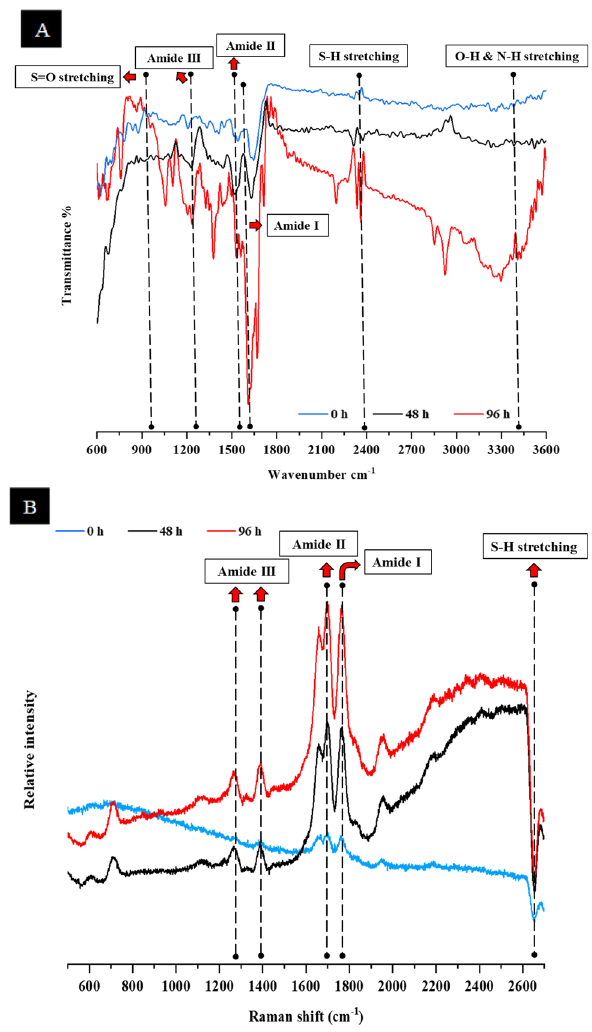
Figure 4. ( A ) Functional group characterization and structural changes in intact (blue) and hydrolyzed feather samples at 48 h (black) and 96 h (red) using ATR-FTIR spectra. ( B ) Chemical fingerprinting of hydrolyzed and unhydrolyzed chicken feathers using Raman spectra of intact feather (blue) and hydrolyzed feathers at 48 h (black) and 96 h (red)